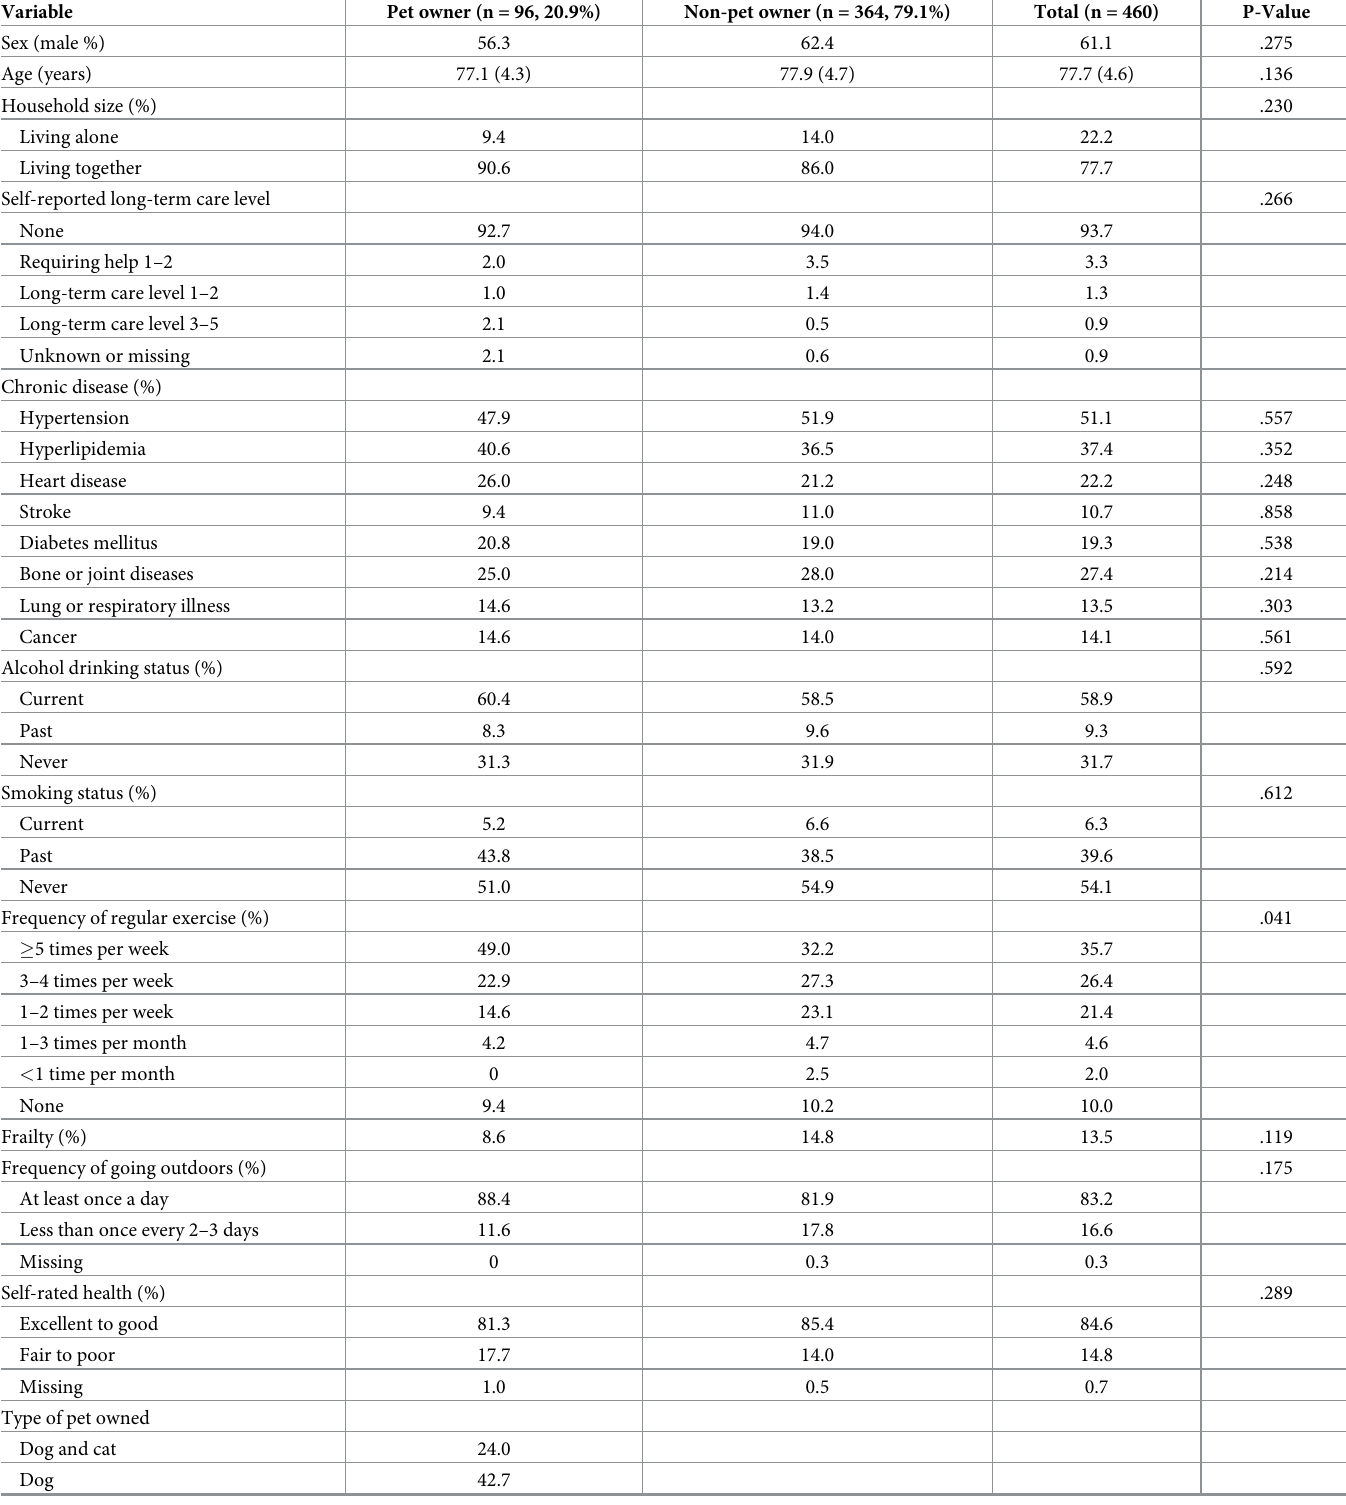
Table 1. Baseline demographic and health characteristics among community-dwelling older Japanese pet owners and